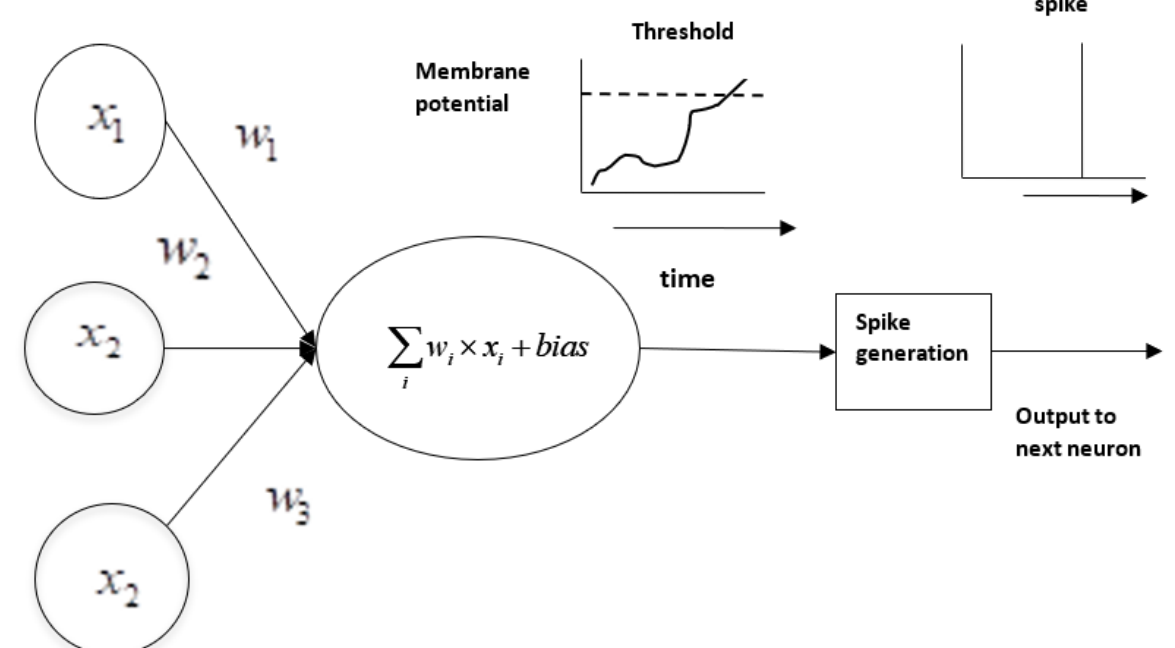
Figure 7. Energy-efficient spiking neural network in